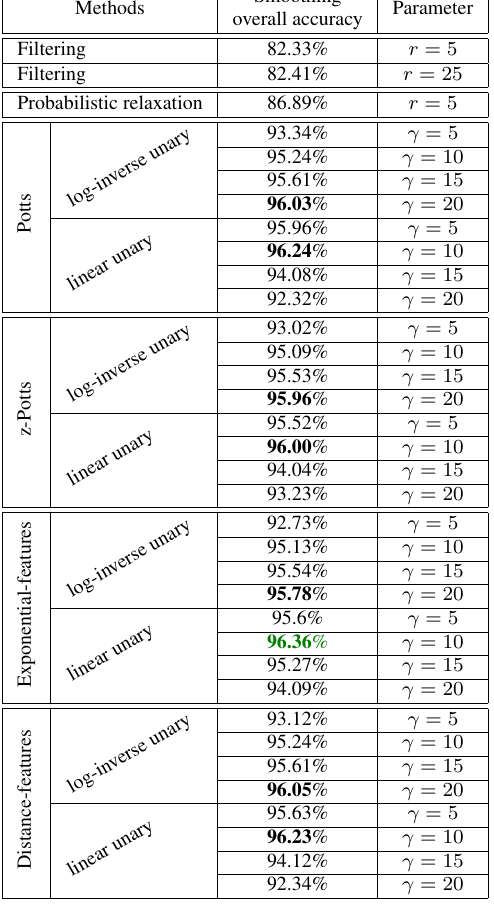
Table 1. Results for the proposed methods for Area 2. The classification has an overall accuracy of 81.41%.